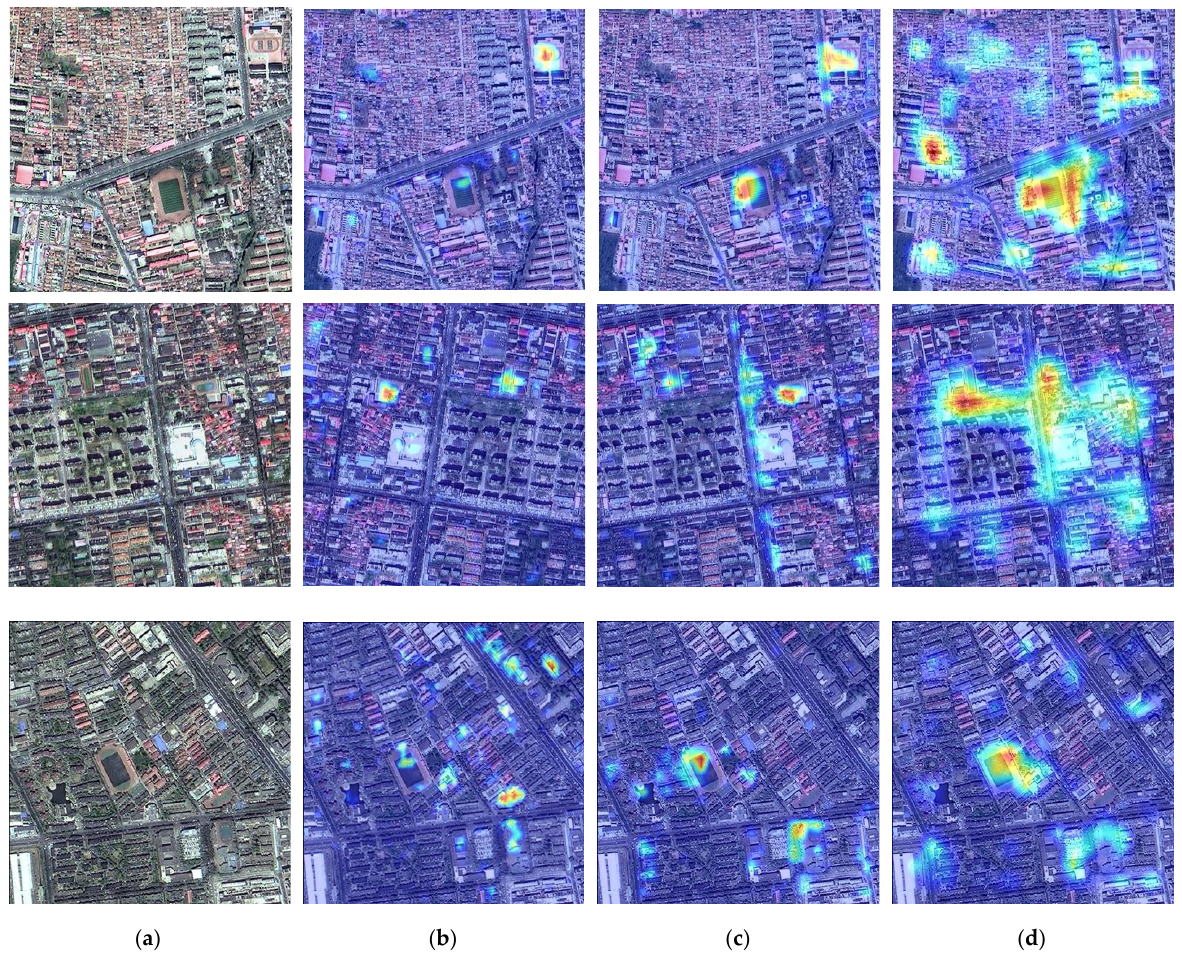
Figure 7. The effect of EFM through the visualizing attention map: ( a ) examples of the input images; ( b – d ) the heatmaps of E3, E4, E5 corresponding images, respectively. ( b – d ) the heatmaps of E3, E4, E5 corresponding images, respectively. Table 3. The comparison of the detection performance among different loss functions of bounding box regression.